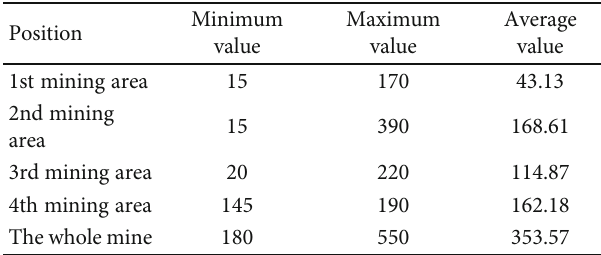
Figure 1: Distribution map of the mining area and geological structure of mine No. 13. Table 1: Undermine water in fl ow of mine No. 13 (m 3